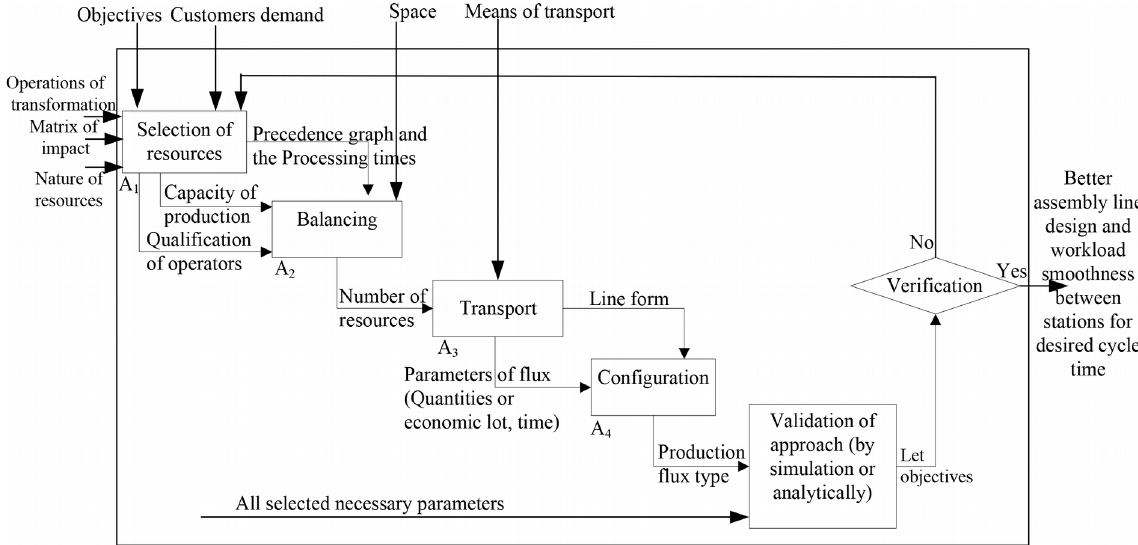
Figure 5. Activity A